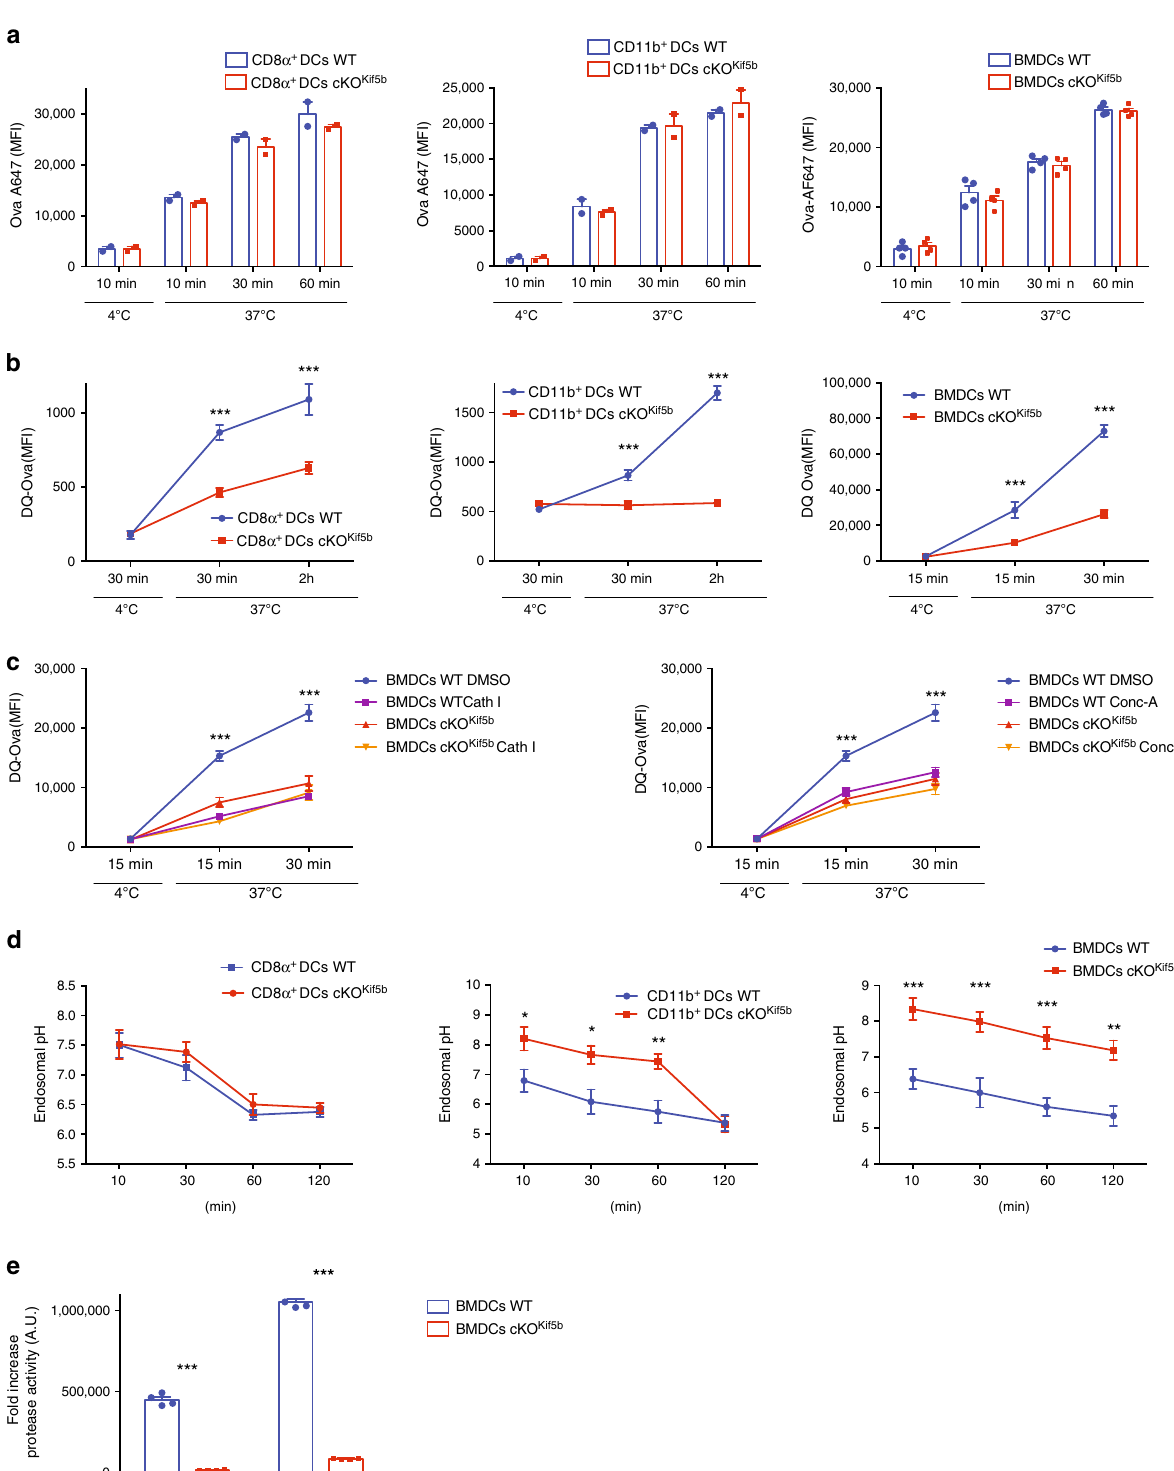
BMDCs did not display any Kif5b labelling - con fi rming the anti- kinesin-1 ’ s role in the dynamics of early compartment motility, we body ’ s speci fi city (Fig. 6a). Confocal immuno fl uorescence images used live cell spinning disk microscopy. After a brief period of revealed greater colocalization of Kif5b with early endosomes than wheat germ agglutinin (WGA) endocytosis (pulsed for 5 min and with recycling endosomes and late endosomes (EEA1/Kif5b over- chased for 5 min), WGA was associated with the early endosomes lap: 53.7% ± 7.7% (Fig. 6b); Lamp1/Kif5b overlap: 36.1% ± 6.7% and colocalized with EEA1-positive early endosomes in BMDCs (Supplementary Fig. 8); Rab11/Kif5b overlap: 29.8% ± 7.5% (Sup- from both WT or cKO Kif5b mice (EEA1/WGA overlap: 81.7% ± 5.7% in WT BMDCs, and 83.7% ± 5.7% overlap in cKO kif5b plementary Fig. 10)); these results suggested that kinesin-1 can BMDCs; Fig. 6c, d). Upon WGA loading, spinning disk microscopy regulate early endosomal compartment traf fi cking. To assess NATURE COMMUNICATIONS| (2020) 11:1817